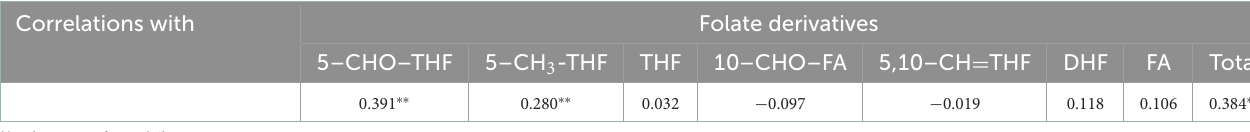
TABLE 2 The contents of different folate derivatives with different NRE levels of cultivars. NRE (%) Folate content ( µ g/100g)